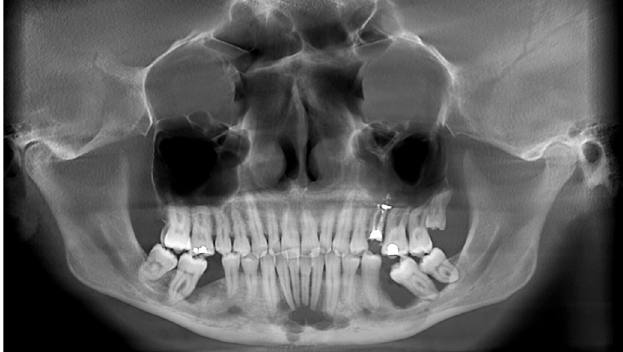
Fig. 2. Panoramic radiograph showing important alveolar bone loss, in particular around left mandibular molars, and multilobular radiolucent image in the periapical area of the mandibular